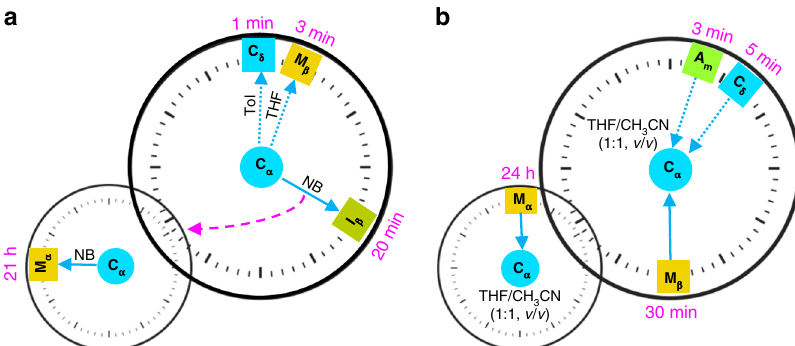
Fig. 4 Time-dependent transformation between various solid materials induced by organic solvents. a Time-dependent conversion of C α to C δ , M β , or I β and then to M α seen upon exposure to different organic vapours. b Time-dependence of the regeneration of C α from different solid forms, namely A m , C δ , M β , and M α , triggered by exposure to the same THF/CH 3 CN (1/1, v / v ) vapour mixture.